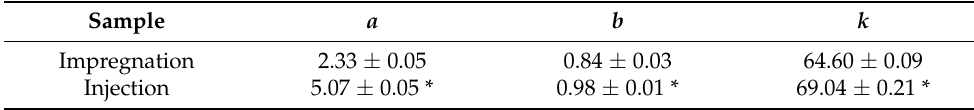
Table 2. Weibull equation constants derived from Figure